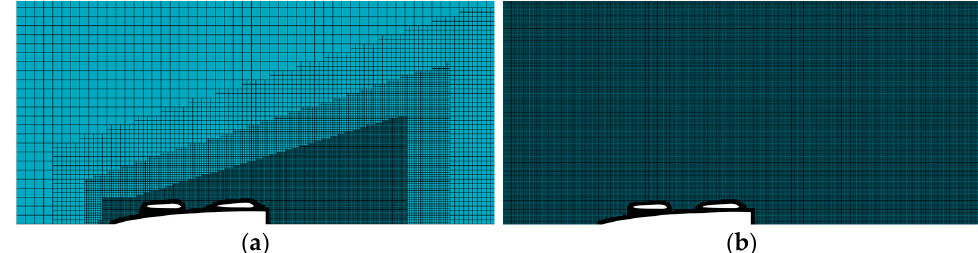
Figure 7. Horizontal section of the mesh: ( a ) calm water condition; ( b ) wave condition. Table 6. Mesh number in calm water and waves.